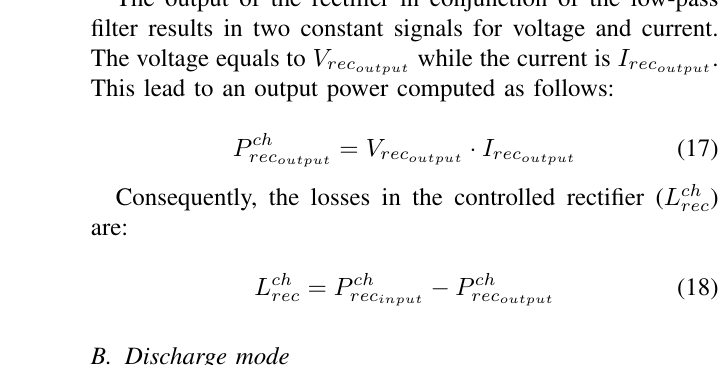
Fig. 4. Voltage (channel 1) and current (channel 2) measurements at the output of the primary DC/AC converter. TABLE III E LECTRICAL SIGNALS MEASURED IN THE PROTOTYPE